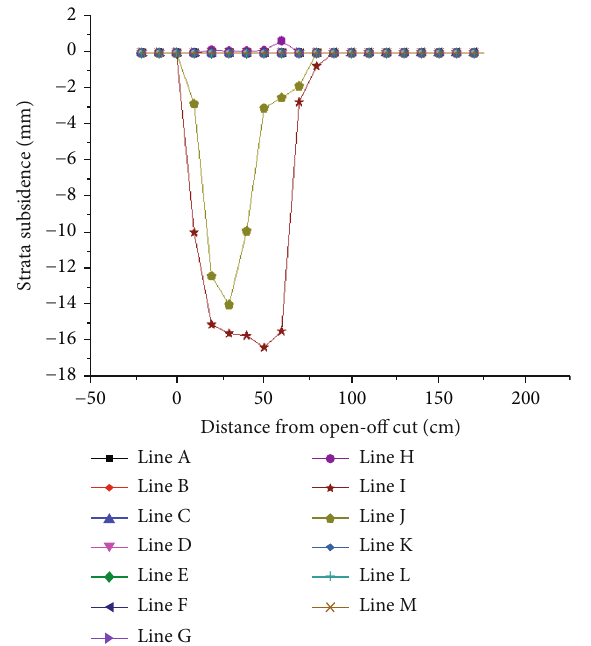
Figure 13: Displacement curve when the W coal working face is pushed 80m.